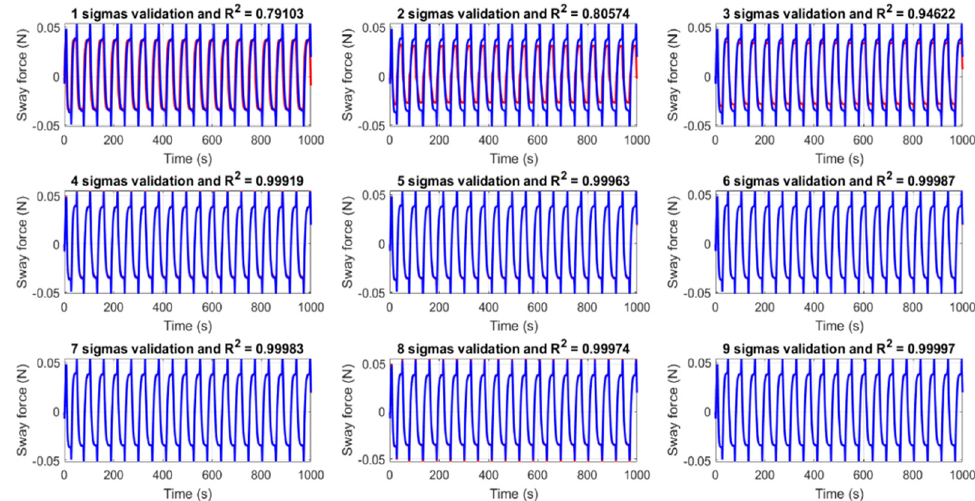
Figure 7. Results from the validation for sway motion with a 20°–20° zigzag manoeuvre.